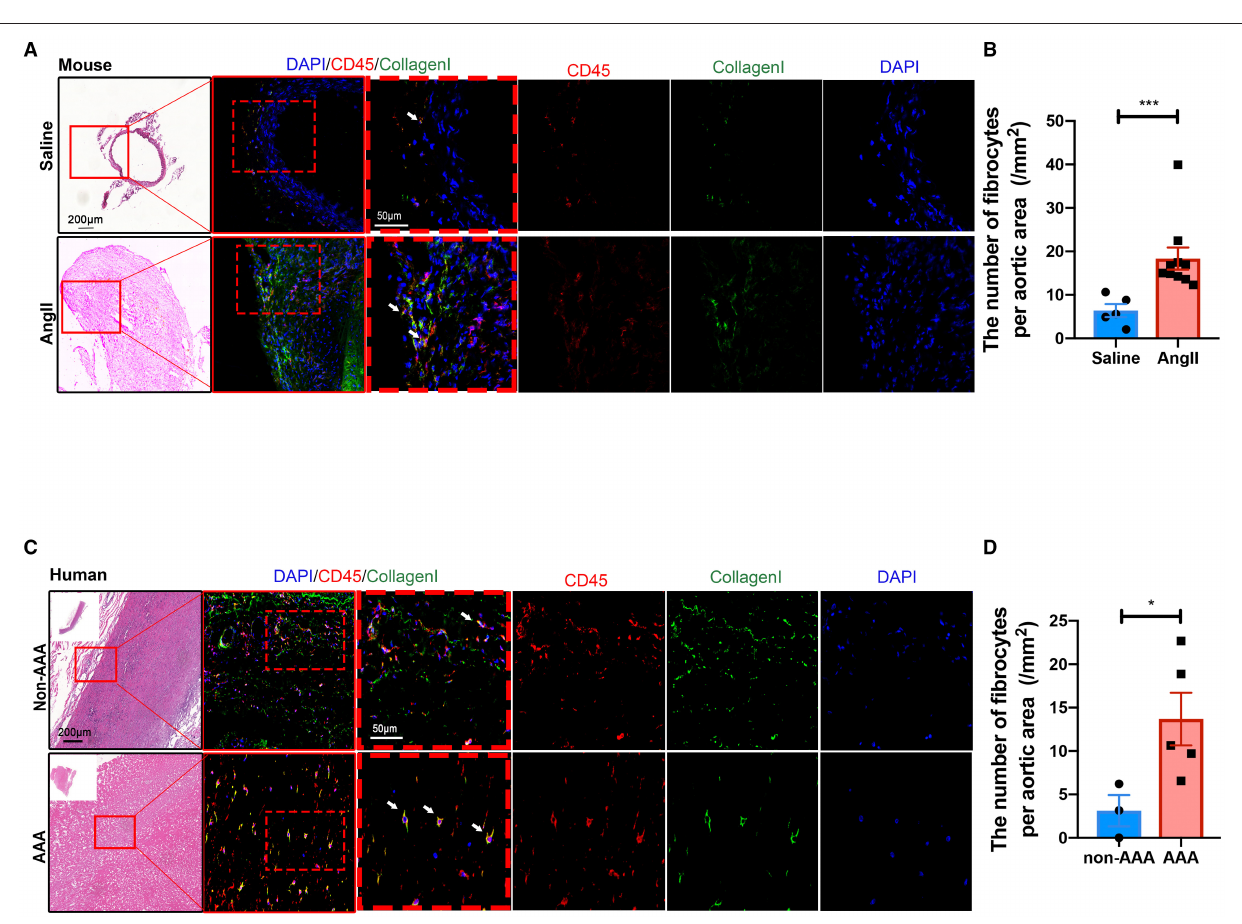
FIGURE 5 | Validation and localization of fibrocytes in AAA. (A) Representative images of H&E staining and the immunofluorescence images of normal aorta and AAA tissue from mice stained with COL1 (green) and CD45 (red). (B) Quantification of the number of fibrocytes per aortic area (/mm 2 ). The quantitative data were shown as mean SEM, and the difference between the groups was evaluated by Mann-Whitney test. (Saline: n 5; Ang II: n 10). (C) Representative images of H&E staining ± = = and the immunofluorescence images of normal aorta and AAA tissue from human stained with COL1 (green) and CD45 (red). (D) Quantification of the number of fibrocytes per aortic area (/mm 2 ). The quantitative data were shown as mean SEM, and the difference between the groups was evaluated by Mann-Whitney test. * p ± < 0.05, and *** p < 0.001. (non-AAA: n 3; AAA: n = =